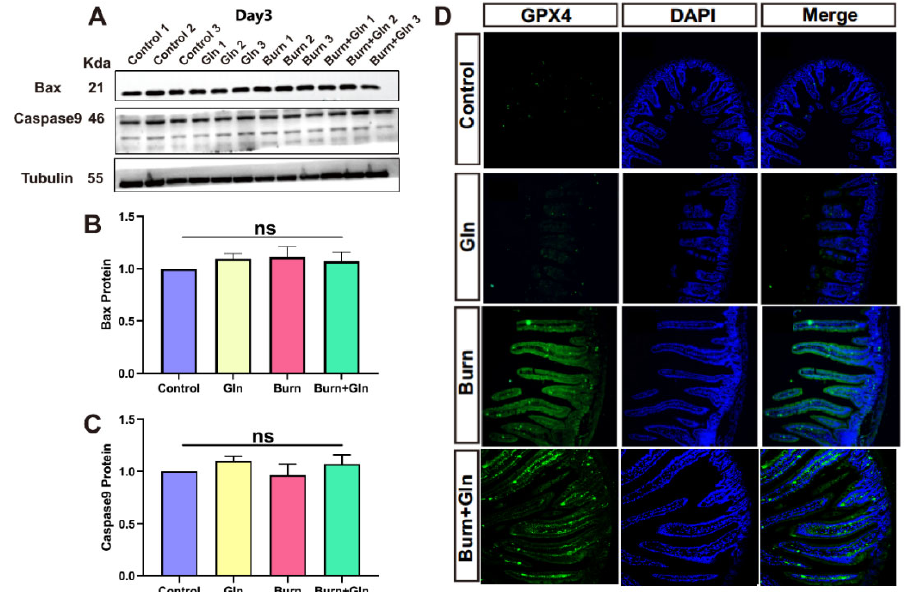
Figure 3. Effects of Gln treatment on apoptosis and ferroptosis in the small intestine after severe burns. ( A ) Gln supplementation after severe burns for 3 days. The expressions of Bax and Caspase9 were detected by immunoblotting ( n = 6). ( B ) The relative intensities of Bax on the 3rd day (Day 3) after burn of bands were quantified using ImageJ. ( C ) The relative intensities of Caspase9 on the 3rd day (Day 3) after burn of bands were quantified using ImageJ. ( D ) Representative images of immunofluorescence for Glutathione Peroxidase 4 (GPX4) (green) and diamidino-phenyl-indole (DAPI) (blue): Control group; Burn group; Gln group; and Burn+Gln group. Data were expressed as mean ± SEM from 6 independent experiments ( n =